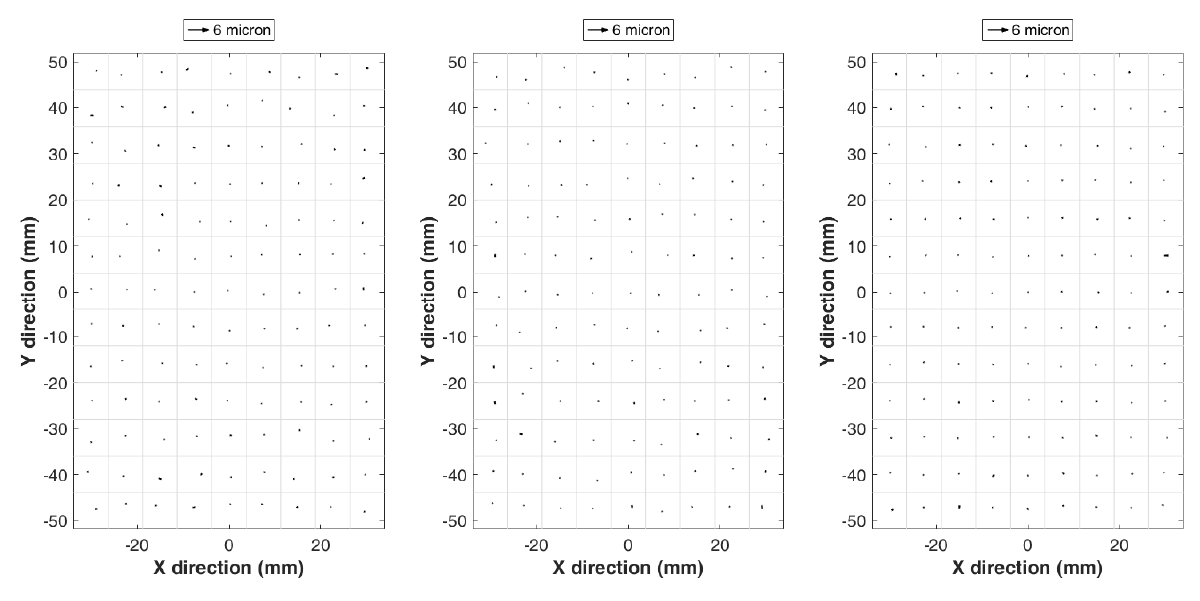
Figure 6. Average residual vectors of the photo coordinate observations in Case 1-2 (left), Case 2-2 (middle), and Case 3-2 (right)